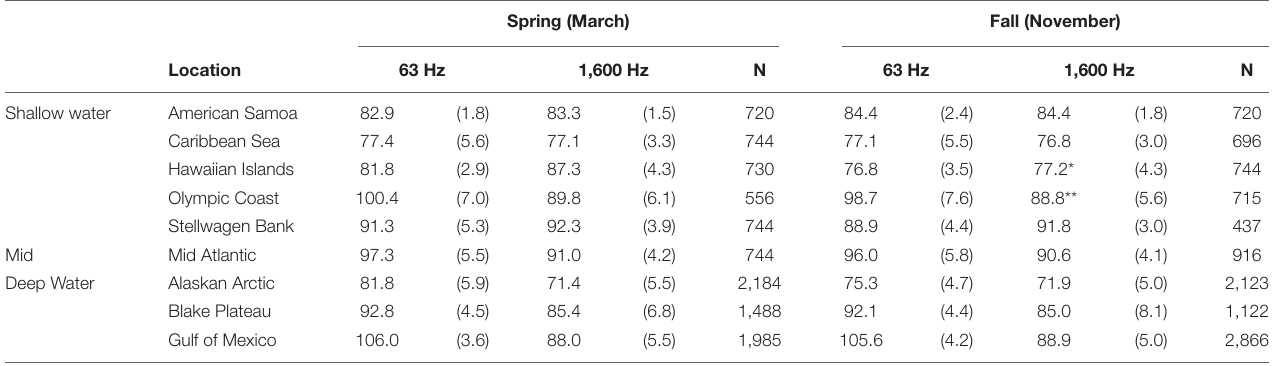
TABLE 2 | Monthly median values at 63 and 1,600 Hz decidecade bands for a representative spring (March) and fall (November)